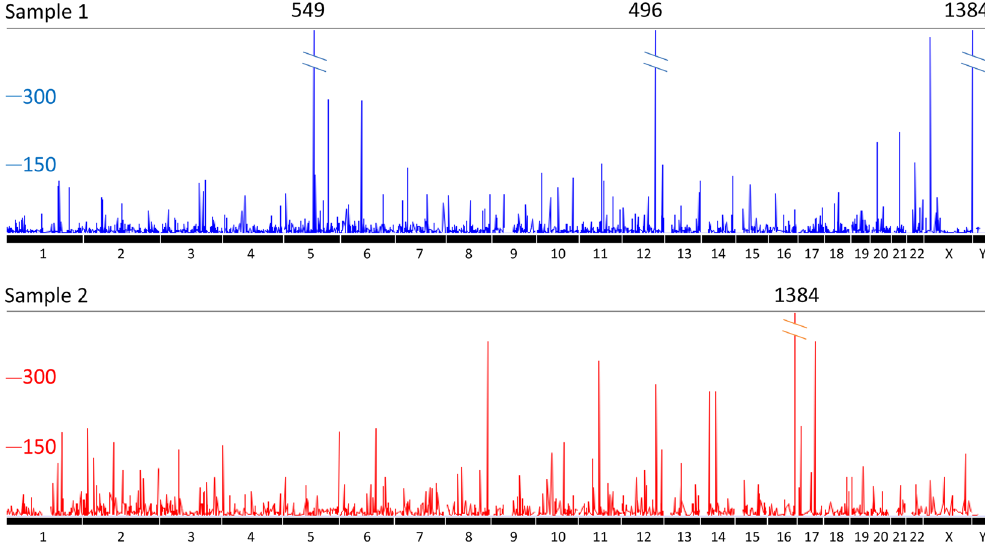
Figure 4. Genome view of eccDNA distribution in samples 1 and 2. The X axis stands for the 23 chromosomes. The Y axis shows the normalized read depth (normalized to total read count of all split reads with read depth ≥ 3).